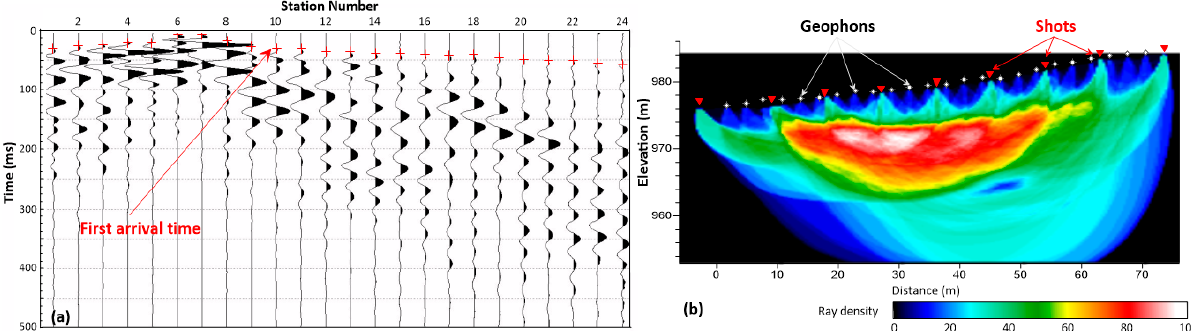
Figure 3. ( a ) Refraction seismic shots recorded during the SRT-2 acquisition with the corresponding Picking analysis; ( b ) Wavepath coverage for the SRT-2.